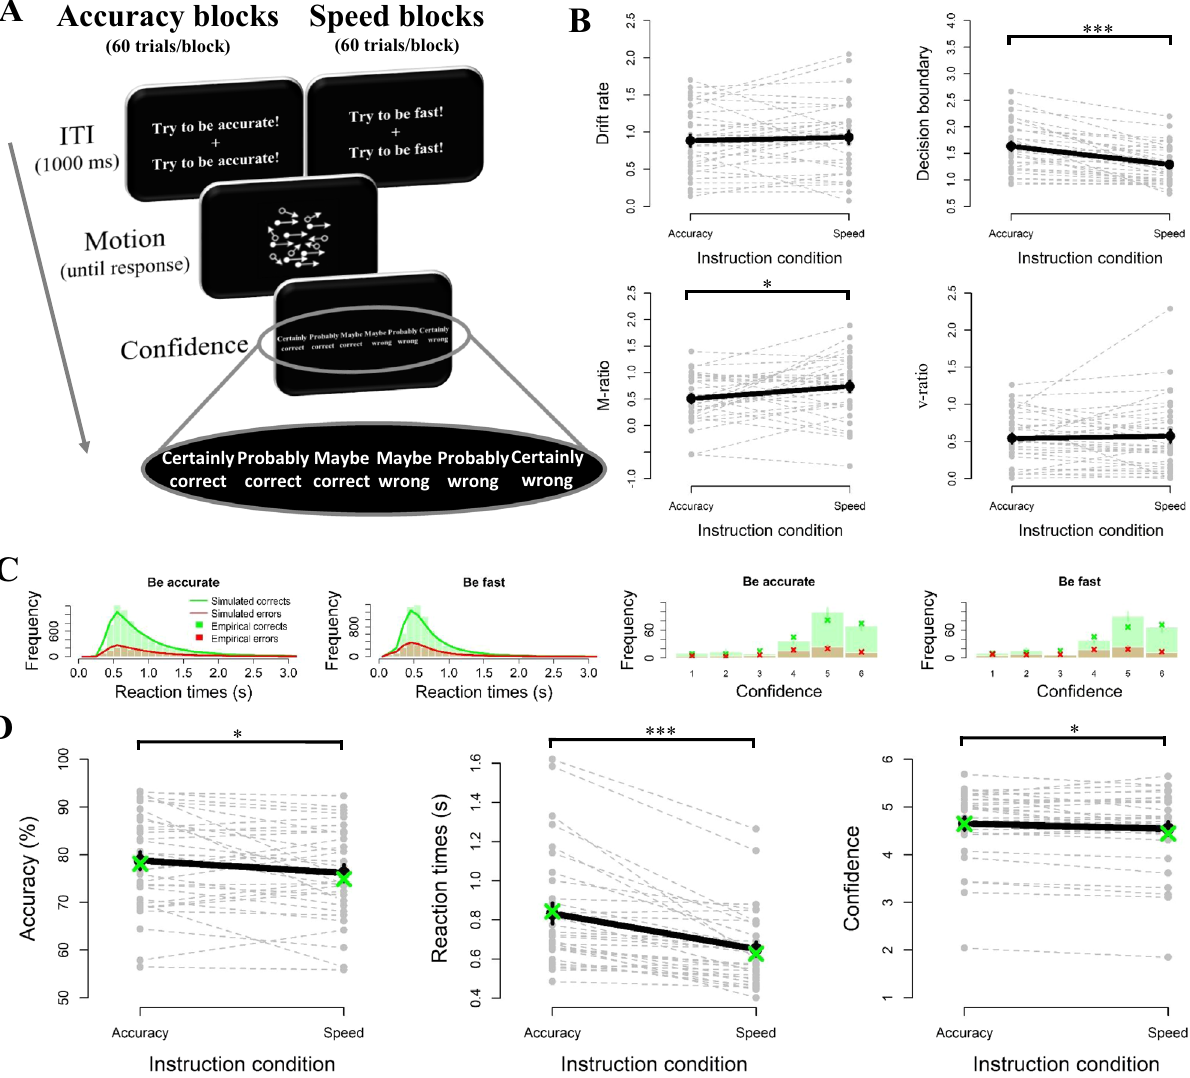
Fig. 2 The in fl uence of speed-accuracy instructions on metacognitive accuracy (Experiment 1). A Sequence of events in the experimental task. Participants ( N = 32) decided whether the majority of dots were moving left or right, by pressing “ C ” or “ N ” with the thumbs of both hands. Immediately after their choice, they then indicated their level of con fi dence using a six-point scale. Depending on the block, instructions during the ITI were either to focus on choice accuracy or to focus on speed. B Fitted parameters of a drift diffusion model with additional post-decision accumulation. Fitted decision boundaries were lower in the speed vs accuracy condition, t(31) = 5.59, p < 0.001, whereas drift rates did not differ, p = 0.478. Critically, M-ratio was higher in the speed vs accuracy condition, t(31) = 2.29, p = 0.029, whereas v-ratio did not differ between both instruction conditions, p = 0.647. C Distribution of reaction times and con fi dence for empirical data (bars) and model fi ts (lines or crosses), separately for corrects (green) and errors (red). D Participants were faster, t(31) = 5.67, p < 0.001, less accurate, t(31) = 2.20, p = 0.035, and less con fi dent, t(31) = 2.41, p = 0.022, when instructed to focus on speed rather than on accuracy. Note: grey lines show individual data points; black lines show averages; green dots show model fi ts; error bars re fl ect SEM; *** p < 0.001, ** p < 0.01, * p < 0.05. Source data are provided as a Source Data fi